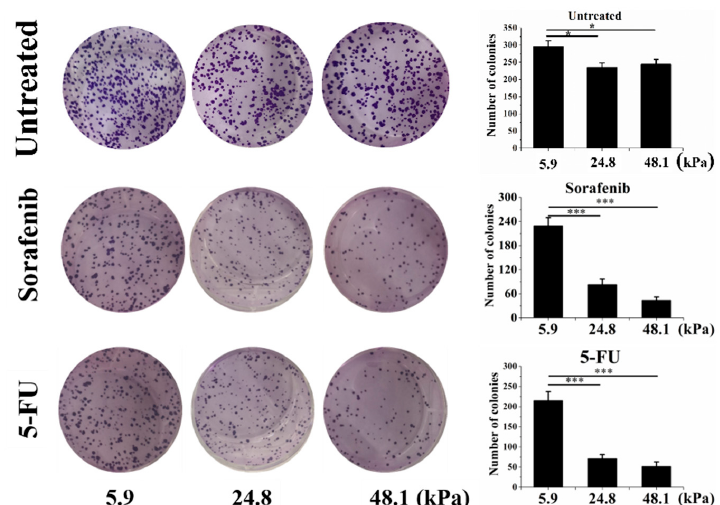
Figure 4. The chemoresistance of cells grown on matrices with different stiffnesses. The untreated control (top), sorafenib (10 µ M; middle) and Fluorouracil (5-FU) (10 µ g / mL; bottom) groups are shown. The values are presented as the mean ± SD of three independent experiments. n = 3; * p < 0.05; *** p < 0.001.